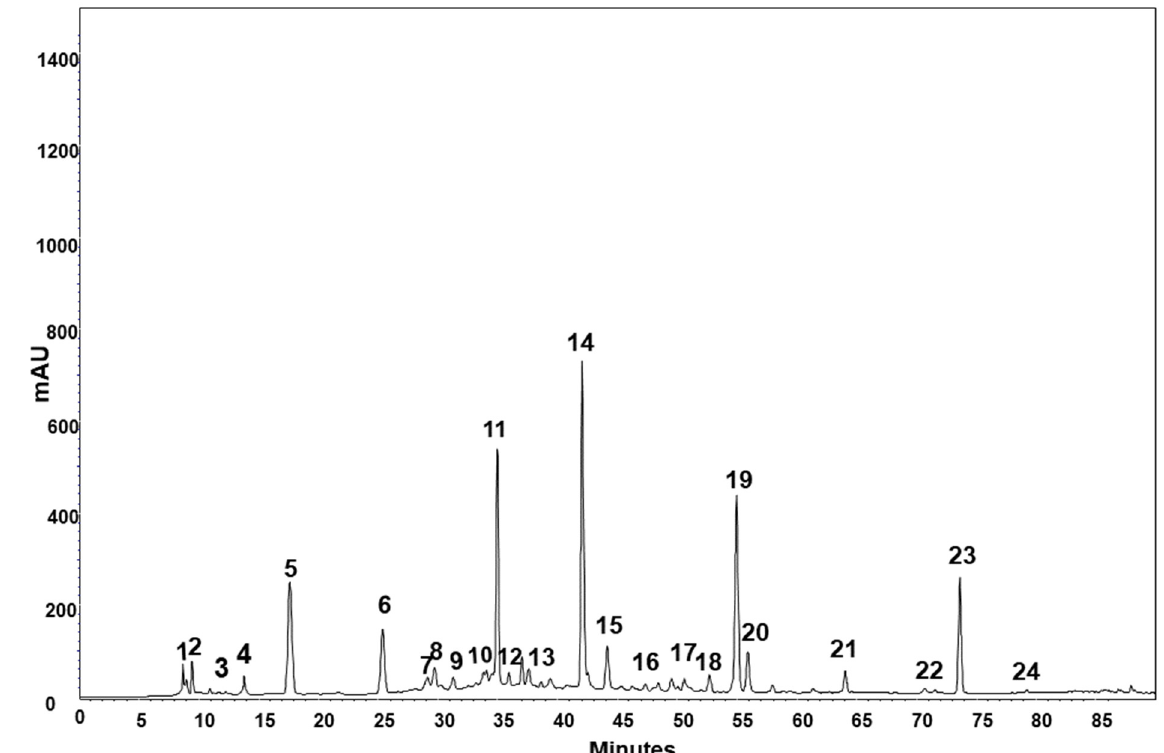
Figure 2. 280 nm-HPLC chromatogram of the phenolic-containing water:methanol extract of Sabal minor seeds. 1. Quinic acid; 2. chelidonic acid; 3. gallic acid; 4. vanillic acid; 5. protocatechuic acid; 6. salicylic acid; 7. 4-hydroxybenzoic acid; 8. DL-p-Hydroxyphenyl lactic acid; 9. 3,4-Dihydroxyhy-